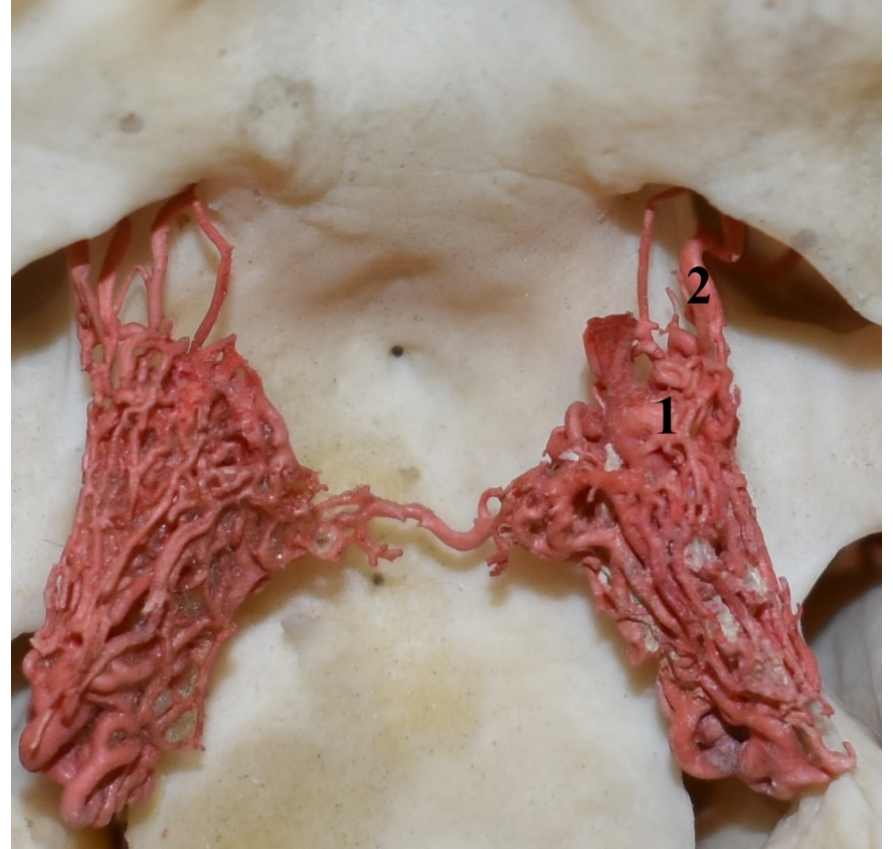
Figure 7. Rostral epidural rete mirabile in the collared peccary ( Pecari tajacu ). A dorsal view and corrosion cast. 1—rostral epidural rete mirabile; 2—rostral branches to the rostral epidural rete mirabile.